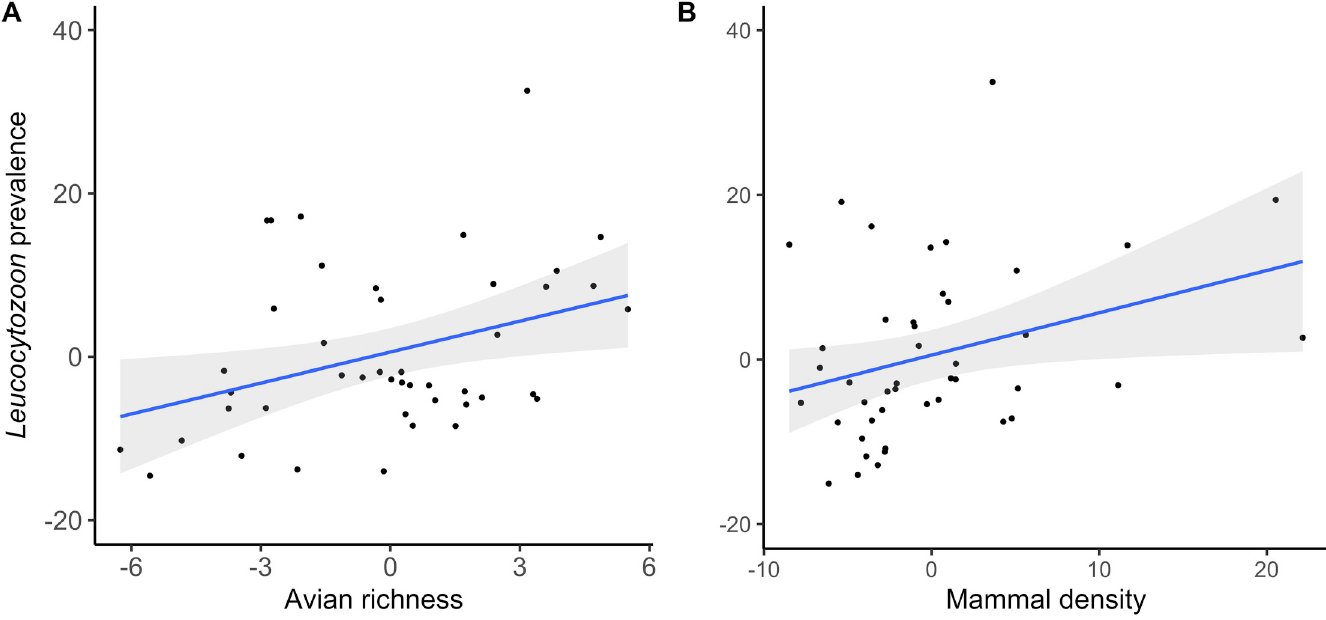
Fig 2. Leverage plots showing the relationships between Leucocytozoon prevalence in house sparrows from the 45 localities included in this study and A) avian richness (estimated from a rarefaction curve) and B) mammal density (sum of the densities of all mammals detected at each locality). The prevalence of Leucocytozoon was calculated using the least squares means of a GLM controlling for birds’ ages and locality. The 95% confidence level interval is shown in grey.